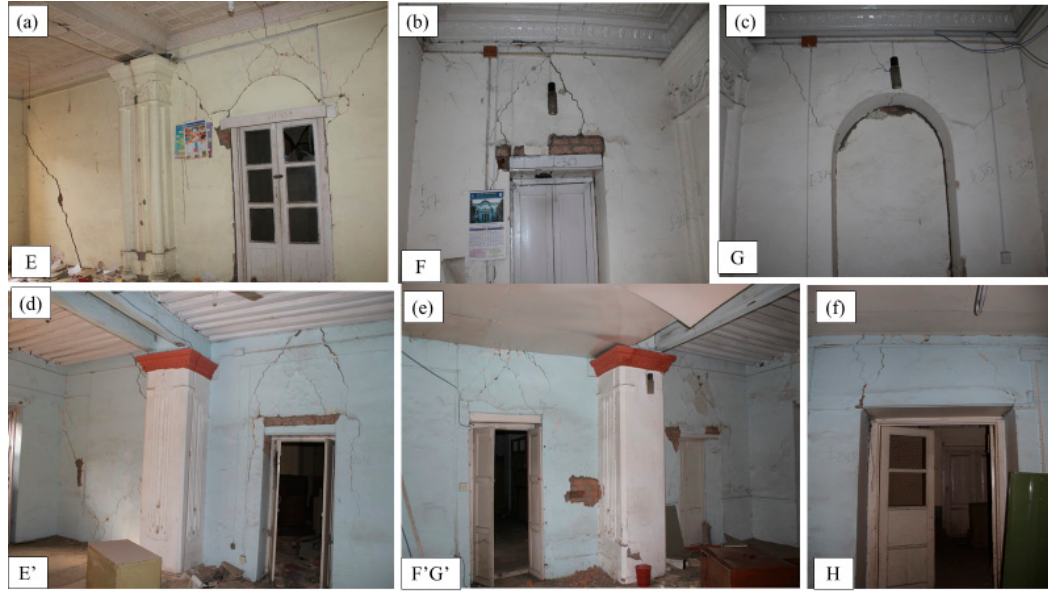
Figure 4. Local damages in the monument ( a ) diagonal cracks on cross-wall, ( b ) damaged wall above the opening, ( c ) damage above the crown of the arch on cross wall, ( d – f ) damages around the openings (uppercase indications at the bottom of the structures are the location indications as shown in Figure